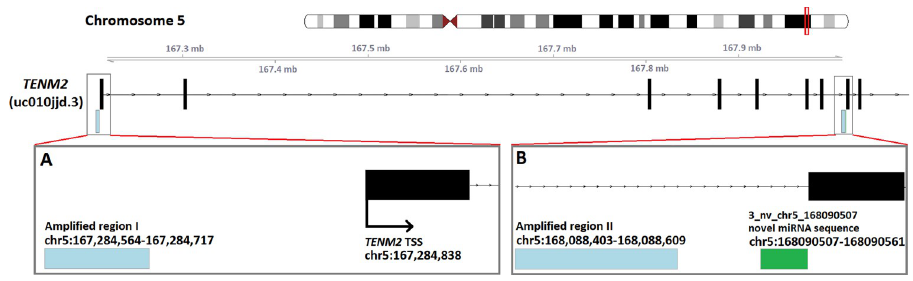
Fig 4. Visualisation of the genomic positions (GRCh38) of bisulfite pyrosequencing assays used for DNA methylation analysis of the novel 3_nv_chr5_168090507 miRNA. Two regions were examined (blue). Region (I) 166 bp upstream of TSS of TENM2 (A) and region (II) adjacent (~2 kb upstream) to novel miRNA gene ( TENM2 intron) (B)